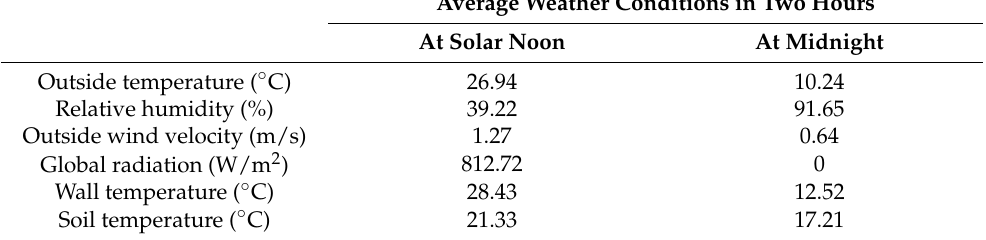
Table 2. Used boundary conditions.